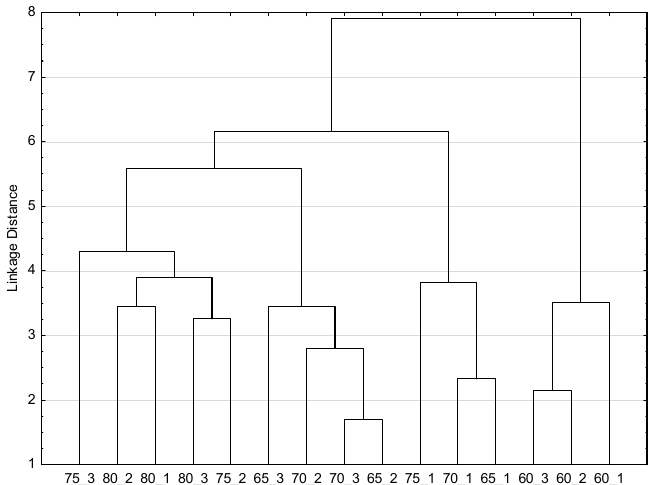
Figure 8. Hierarchical cluster analysis dendrogram of the data matrix.